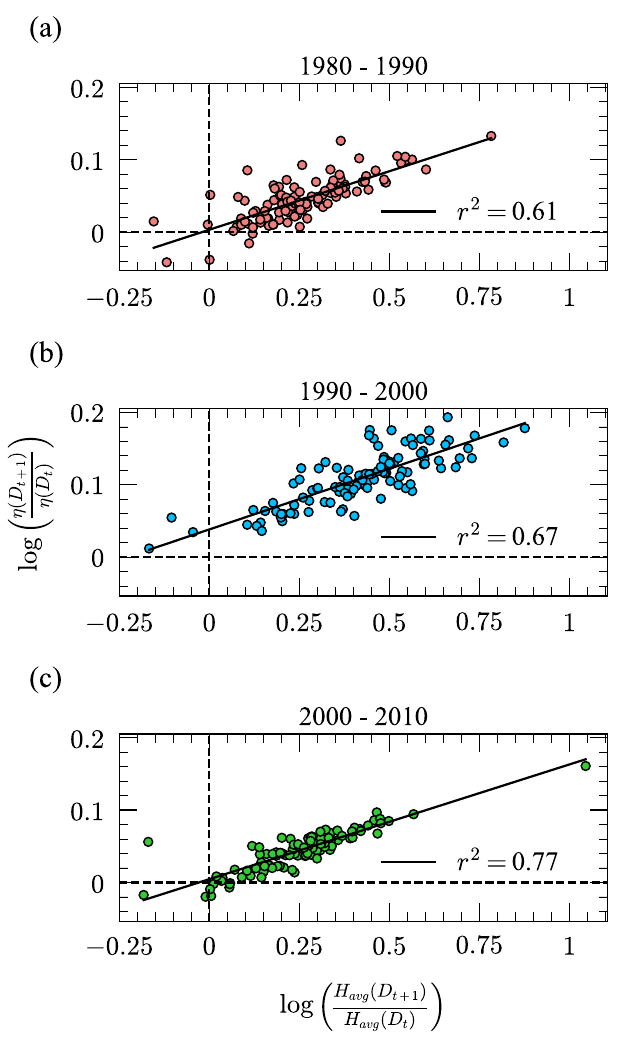
Fig. 3 Compression versus small-scale diversity. Log-ratio of consecutive inverse compression ratios η (Eq. (18)) versus the log-ratio of consecutive average tract-level diversities H avg (Eq. (6)), in U.S. metros over the decades a t = 1980 − 1990, b t = 1990 − 2000, and c t = 2000 − 2010. Dotted lines at x = 0 and y = 0 are displayed for reference, along with ordinary least squares regression lines (solid black) and their coef fi cients of determination r 2 . The slopes of all regression lines were highly statistically signi fi cant at the 0.01 signi fi cance level. Without grouping the changes by decade, we fi nd r 2 = 0.70, and that the slope is again highly signi fi cant at the 0.01 signi fi cance